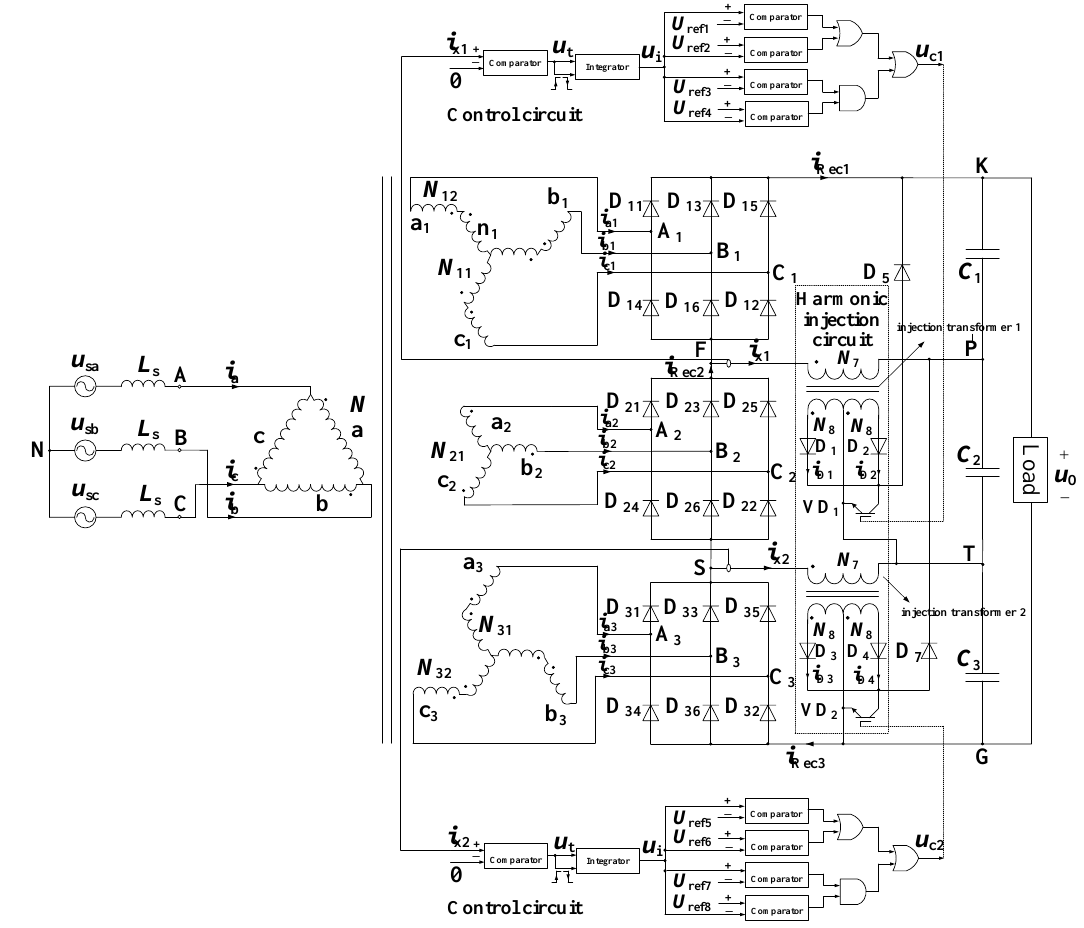
Figure 1. The proposed multipulse rectifier using hybrid harmonic reduction method.